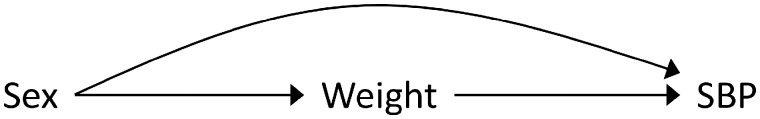
Directed acyclic graph (DAG) depicting the hypothesized causal relationships between sex, weight and systolic blood pressure (SBP).